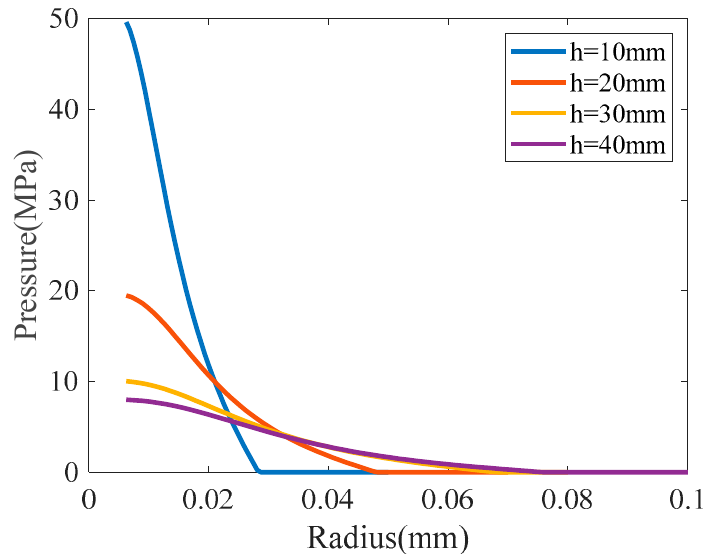
Figure 4. Contact pressure distribution for different thicknesses. To clarify the affection of tightening force, the bolt diameter and thickness are constant, and the contact pressure distribution between the plates under different tightening forces is drawn in Figure 5. The same process is performed to clarify the affection of bolt diameter, material, and roughness. The result shows that the affection of bolt diameter on the contact pressure distribution of joint bolt connection structures is not